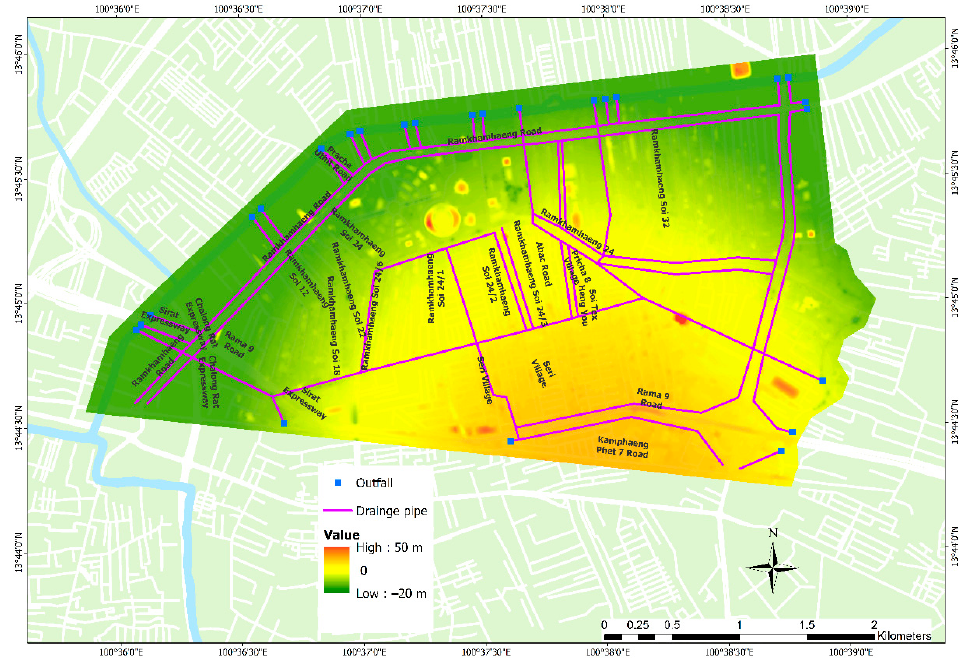
Figure 8. The model setting of the 1D drainage pipe/secondary canal network on the 2D DEM ter- rain.